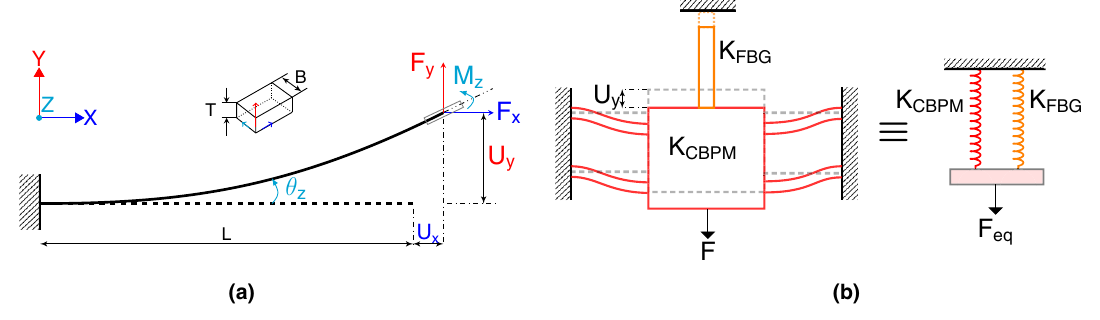
Figure 8. ( a ) Deformation of a flexural beam; ( b ) deformation of the four-arm